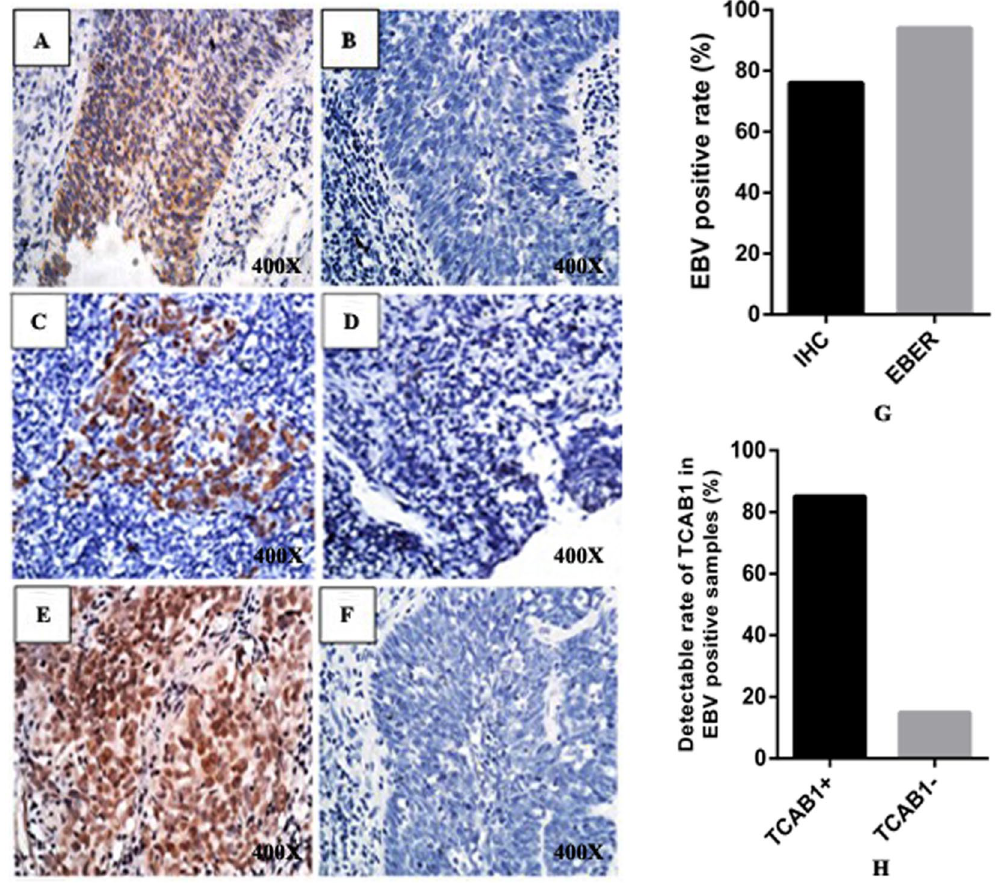
Figure 1. Representative photographs of LMP1 and TCAB1 expression in clinical samples of nasopharyngeal carcinoma (NPC), as detected by immunohistochemistry and in situ hybridisation. Typical IHC results for LMP1 (( A ) positive ( B ) negative) in human NPC samples. Typical in situ hybridisation results for EBER (( C ) positive ( D ) negative) in human NPC samples. Typical IHC results for TCAB1 (( E ) positive ( F ) negative) in human NPC samples. ( G ) The detection rate of EBV-positive specimens by IHC and in situ hybridisation. ( H ) Percentage of TCAB1-positive and -negative specimens among EBV-positive samples.